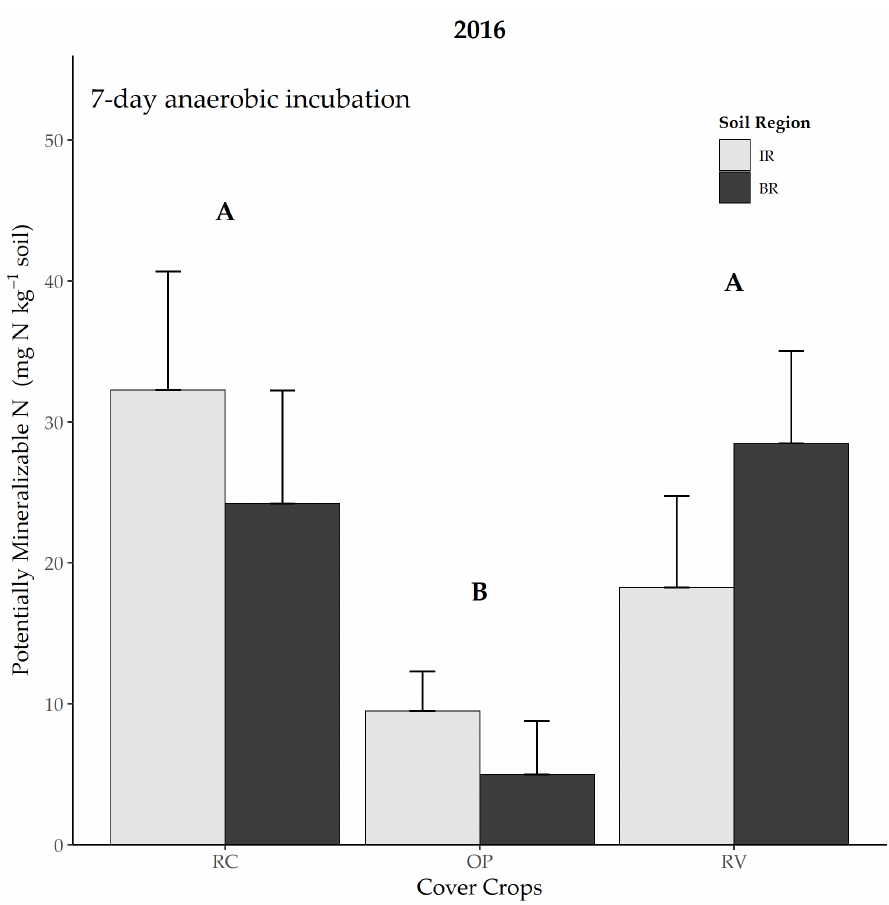
Figure 3. Effect of cover crop system on potentially mineralizable N at the post-kill sampling time in 2016. Error bars represent one standard error. Different capital letters over bars represent a difference between cover crop systems at p < 0.05. OP = oat + field pea, RV = winter rye + hairy vetch, RC = medium red clover. IR = in rows, BR = between rows.